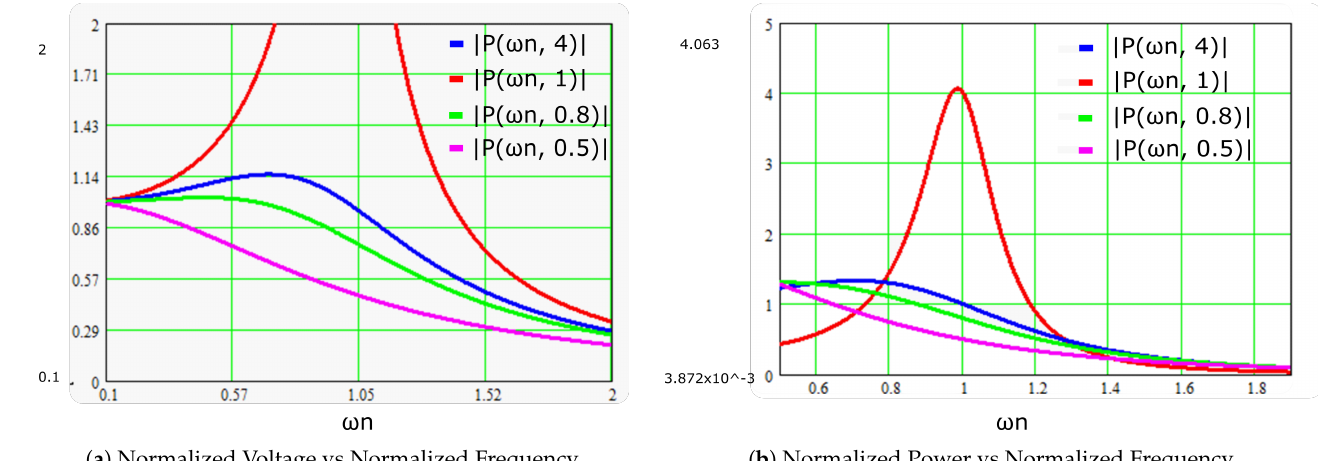
( a ) Normalized Voltage vs Normalized Frequency. ( b ) Normalized Power vs Normalized Frequency. Figure 4. Output parameters for several normalized output loads vs. normalized